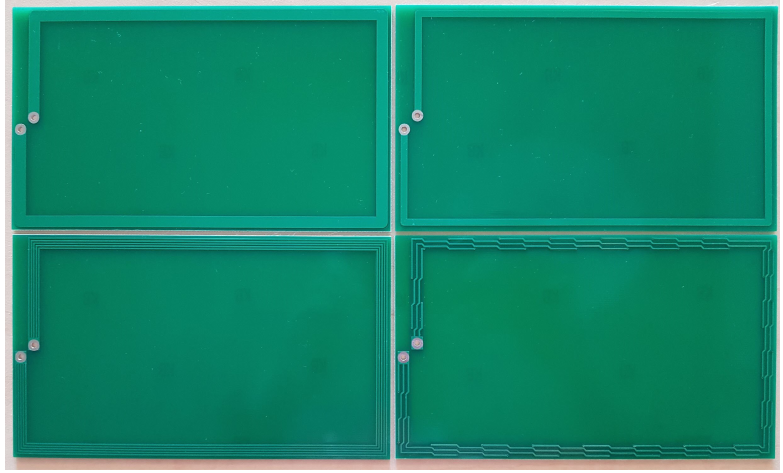
Figure 7. Single turn PCB windings with solid 5 mm ( Top Left ), solid 3 mm ( Top Right ), multi-strands ( Bottom Left ) and Litz style ( Bottom Right ).